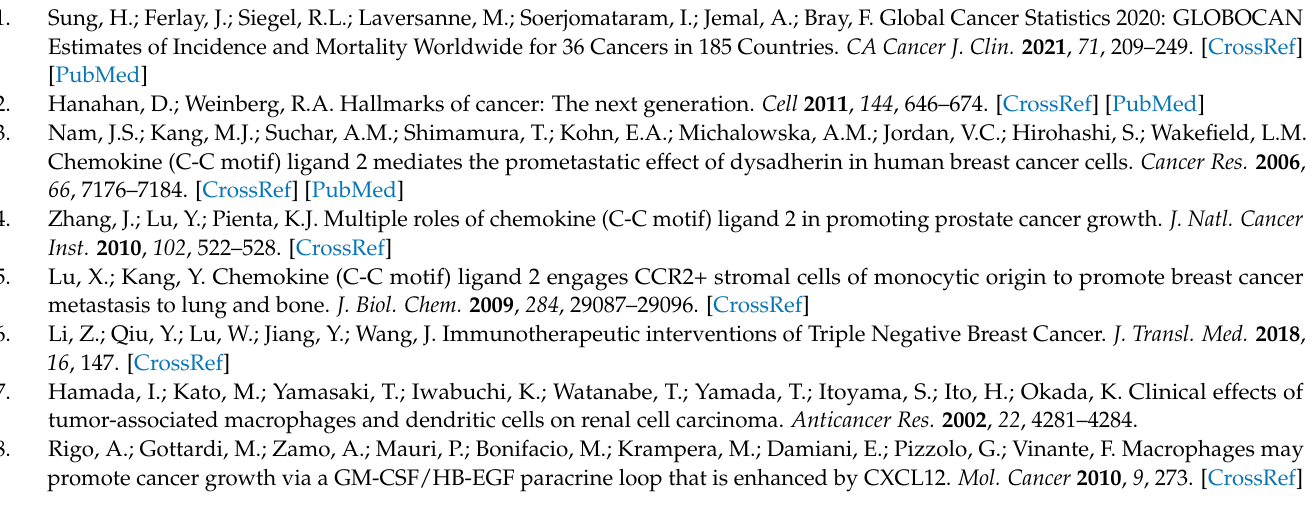
Table S2: Statistical analysis of genes expressed between samples with 50 highest or lowest risk scores in TCGA-BRCA cohort. Supplementary Table S3: GO-GSEA analysis result based on the differentially expressed genes from Supplementary Table S2. Supplementary Table S4: Statistical analysis of estimated immune infiltration data between high- and low-risk score groups in TCGA-BRCA cohort. Supplementary Table S5: Linear regression analysis result of the risk score and estimated drug IC50 values in TCGA-BRCA cohort. Supplementary Figure S1 and related methods: Cell malignances induced by TAMs. Supplementary Figure S2: Association of the risk score with clinical and biological features in MBC